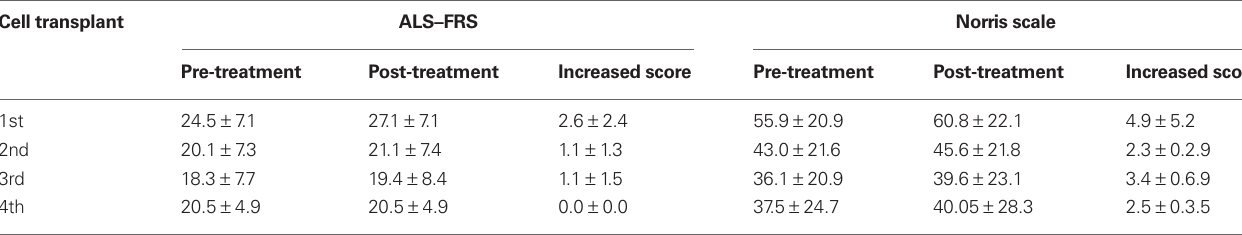
Table 3 | Amyotrophic lateral sclerosis–FRS and Norris scale score and increased score after four treatments. Cell